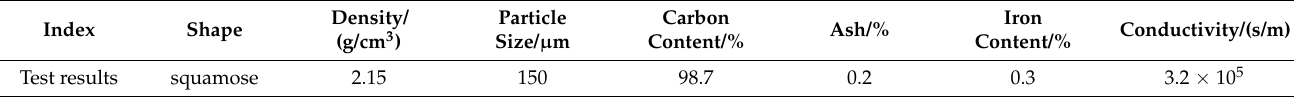
Table 5. The main properties of graphite.